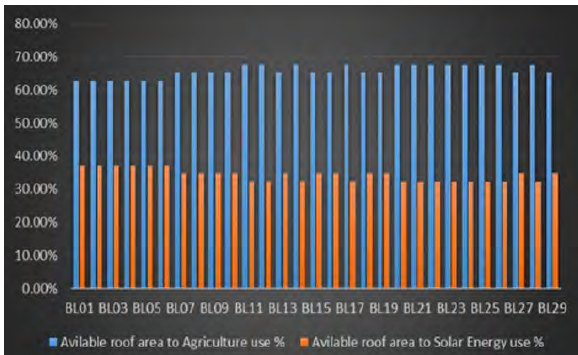
Figure 18. Available roof area for Agriculture use % & Available roof area for solar cells use